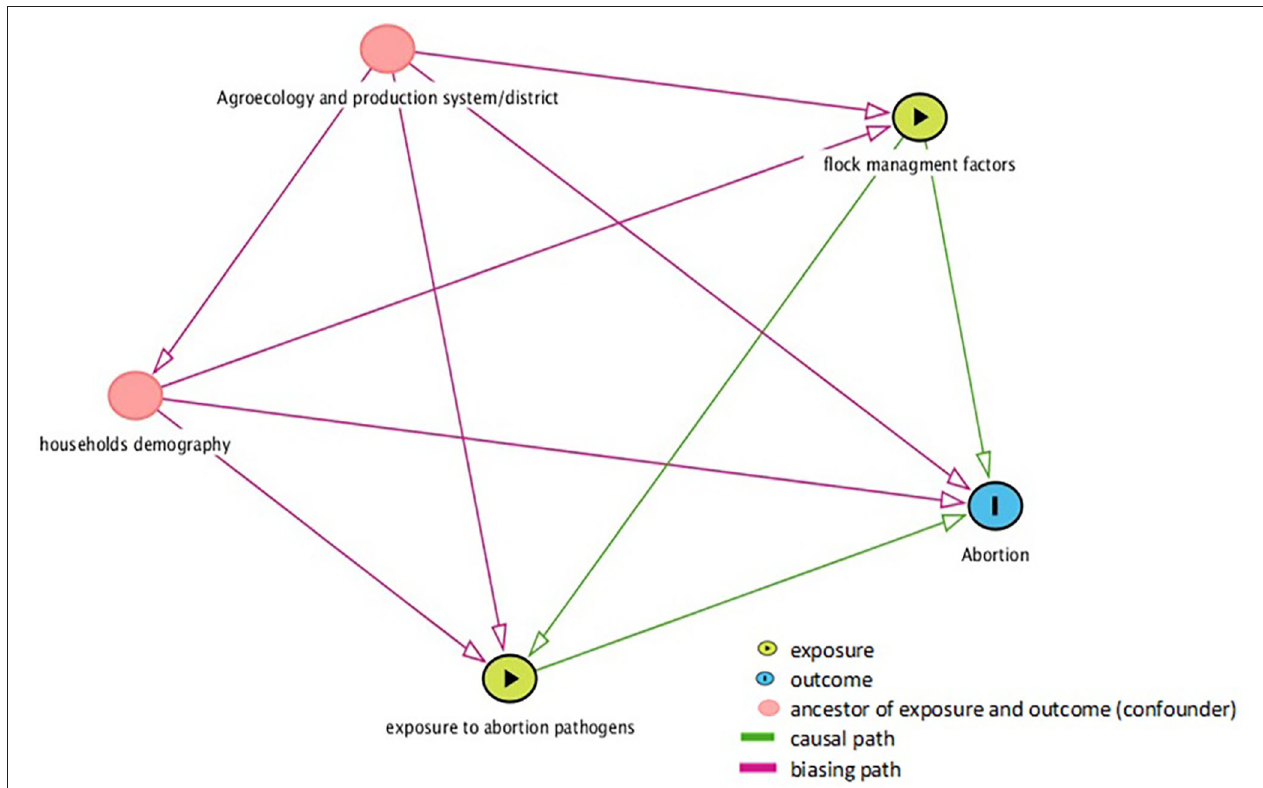
FIGURE 2 | Causal diagram generated in DAGitty (30) postulating the relationships between the potential predictors and small ruminant abortion sampled in three agroecology and production system of Ethiopia.